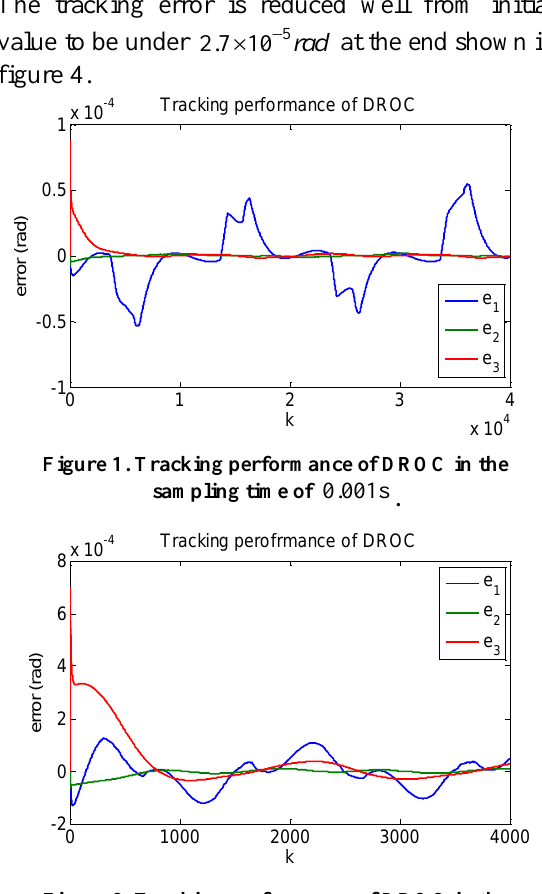
Figure 2. Tracking performance of DROC in the sampling time of 0.01s .